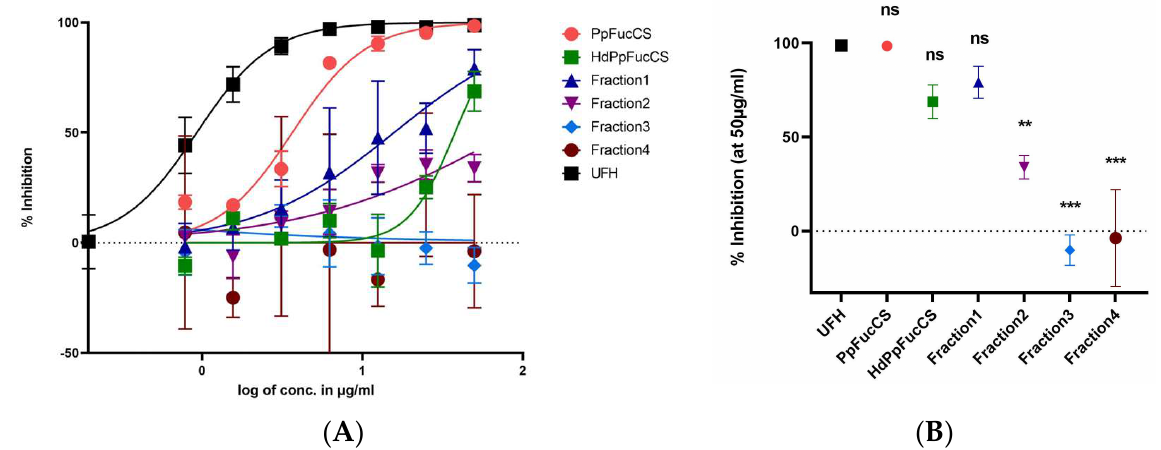
Figure 2. Anti-HCMV activity of PpFucCS oligosaccharides. PpFucCS oligosaccharides were assayed for their potential to inhibit the HCMV (GFP-tagged TowneBAC strain) infection in HFFs (MOI 0.1) by enumerating the cells expressing GFP. ( A ) Normalized values from the assay were analyzed by nonlinear regression to fit a dose–response curve using the least squares method considering each repeated measure as an individual point. The plotted curve shows the percentage of HCMV inhibition in a (log) concentration-dependent manner. Curves in the plot represent the following: PpFucCS (red), HdPpFucCS (green), Fr1 (navy), Fr2 (purple), Fr3 (blue), Fr4 (brown), and UFH (black). ( B ) Using the normalized values from the same assay, we calculated the percentage inhibition at the maximum concentration used (Imax) and compared with the UFH at the same concentration (50 µ g/mL) by performing one-way ANOVA test with multiple comparisons by comparing the means of each test with control UFH, and corrected using a Dunnett’s post hoc test, showing significant differences among the means. The results are representative of three independent experiments. The standard error of the mean was plotted as error bars. The ***, **, and ns (non-significant) indicate p -value < 0.001, from 0.001 to 0.01, and ≥ 0.05, respectively. Table 1. IC 50 values of anti-viral activities of PpFucCS and its oligosaccharides. The IC 50 values of anti-HCMV inhibitory activity of PpFucCS and its oligosaccharides were determined in HFFs. Con- sidering the role of avidity often found in protein‒glycosaminoglycan (GAG) interactions and the broad range of molecular weights of the compounds, IC 50 values were measured in terms of µg/mL rather than the molar units. ND, not detected.